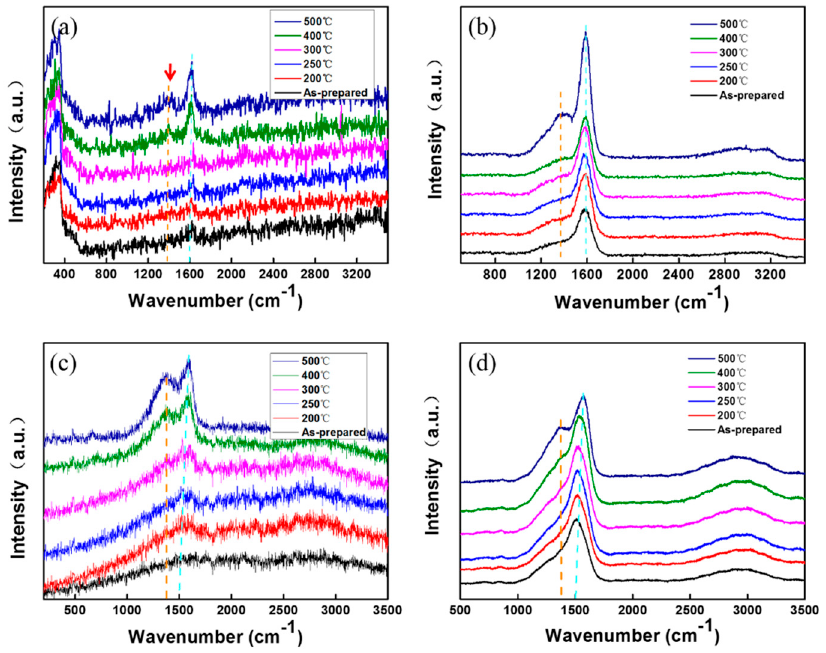
Figure 3. Raman spectra of thin ( a ) and thick ( b ) FL-C:H films in different annealing temperatures for λ L = 325 nm, Raman spectra of thin ( c ) and thick ( d ) FL-C:H films in different annealing temperatures for λ L = 532 nm.